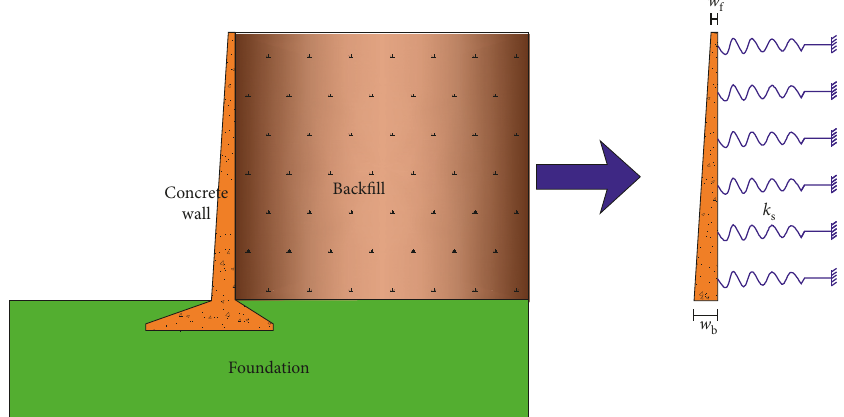
Figure 1: Cross section of a cantilever retaining wall and the mechanical model.